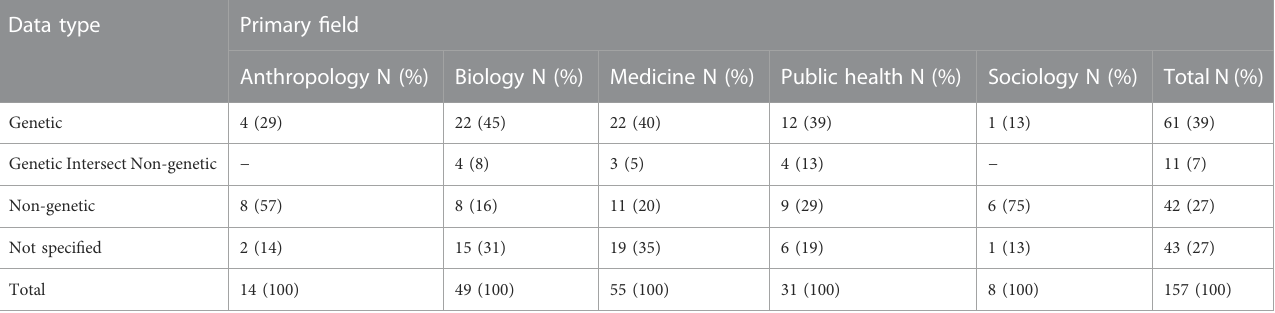
TABLE4Typesofdatausedtooperationalizeancestrybyarticlesindifferent fi elds.Notethatthe 8articles thatoperationalizedancestryinmore thanonewayappear more than once in this table.